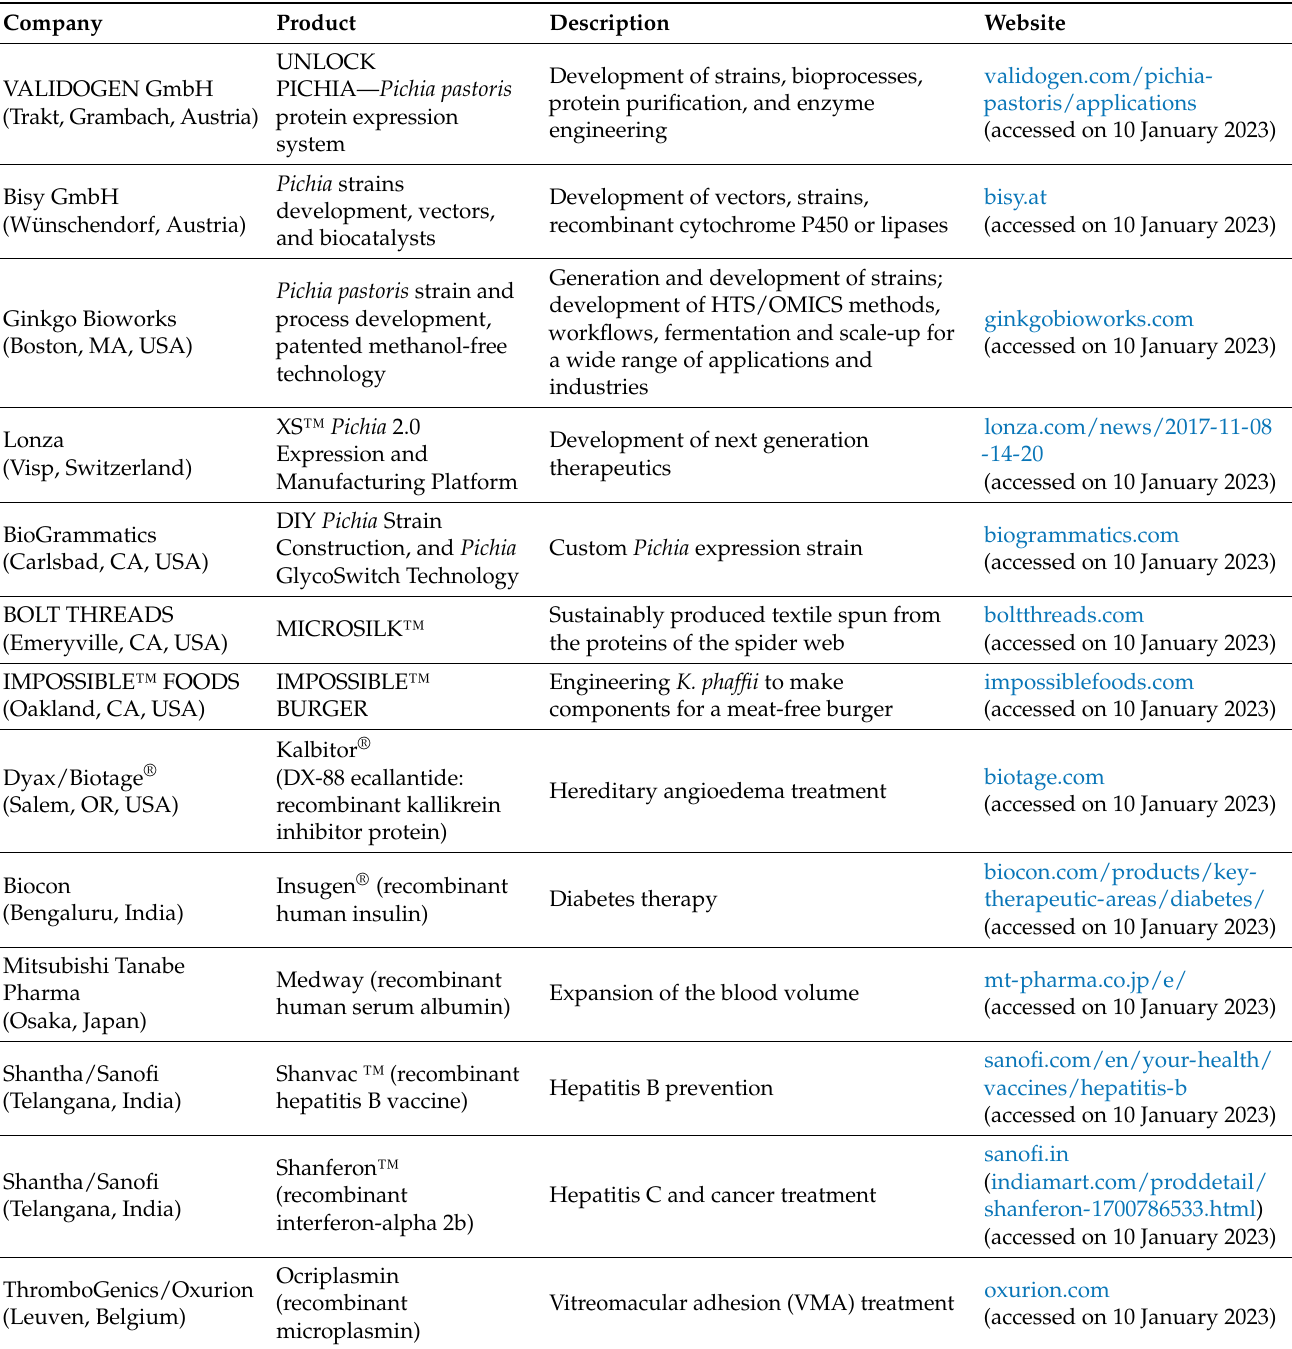
Table 4. Non-confidential examples of engineered K. phaffii in different worldwide companies aiming at the production of target proteins. The following public data were taken from the RESEARCH CORPORATION TECHNOLOGIES [111] official company websites, white papers, or